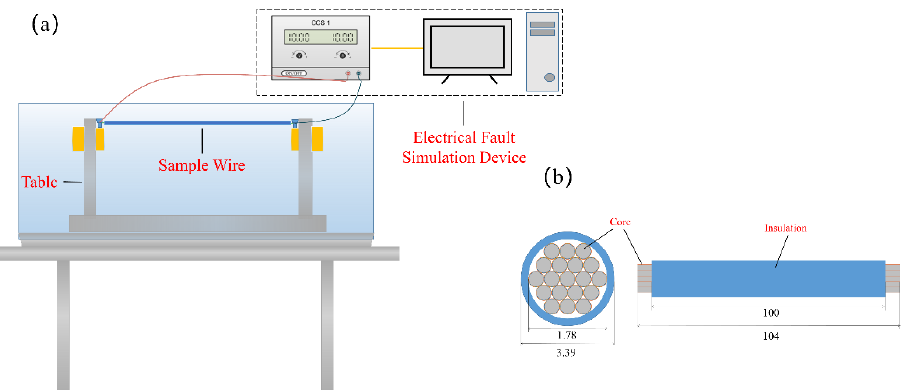
Figure 1. Schematic of the experimental apparatus: ( a ) electrical fault simulation device and ( b ) sample wire.